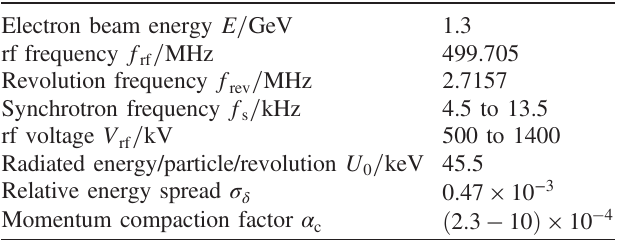
TABLE I. Typical parameters during